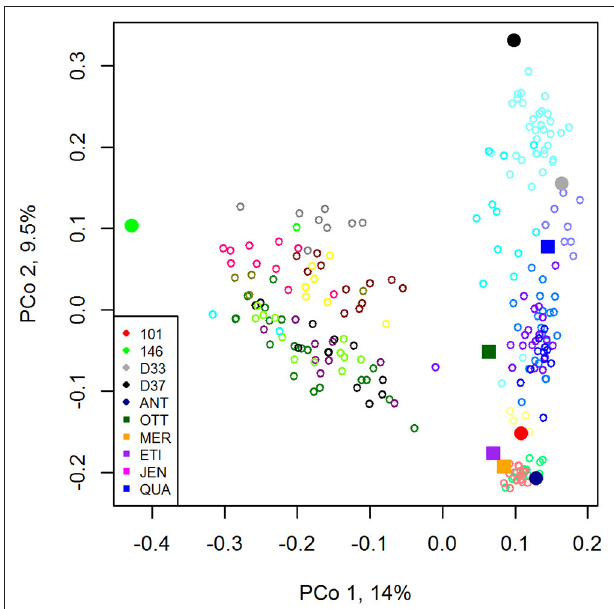
FIGURE 1 | Principal coordinates analysis plot with nine parental lines and 239 emerging DH lines. Parental lines: filled symbols. Circles: resistance donors, Squares: elite lines. DH lines: bordered circles with 19 different colors representing the crosses with viable